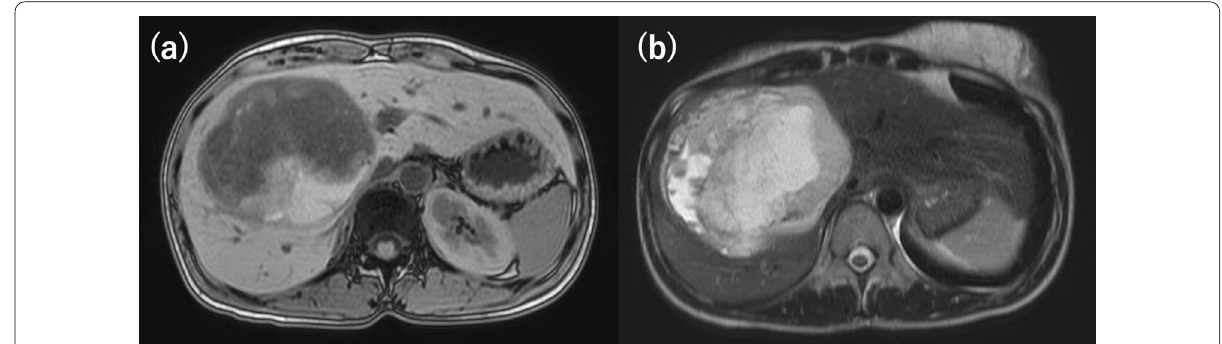
Fig. 2 a Magnetic resonance imaging reveals a hypointense multicystic tumor on T1-weighted and b hyperintense on T2-weighted images